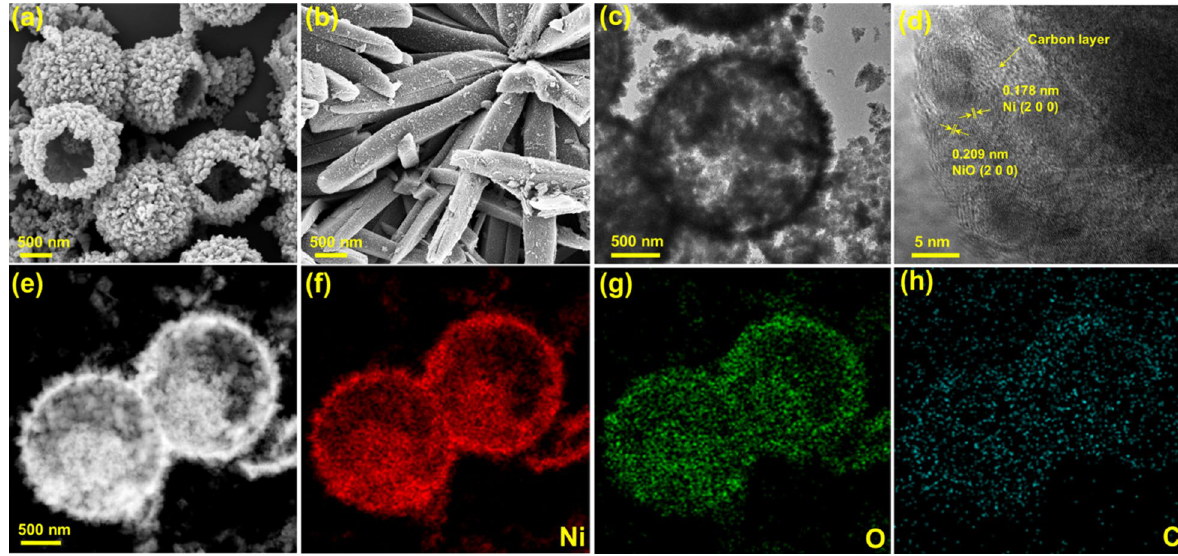
Fig. 2 SEM images of a H–Ni/NiO/C and b NH–Ni/NiO/C, c TEM, d HR-TEM, e Scanning TEM images of H–Ni/NiO/C with corresponding element maps of f Ni, g O, and h